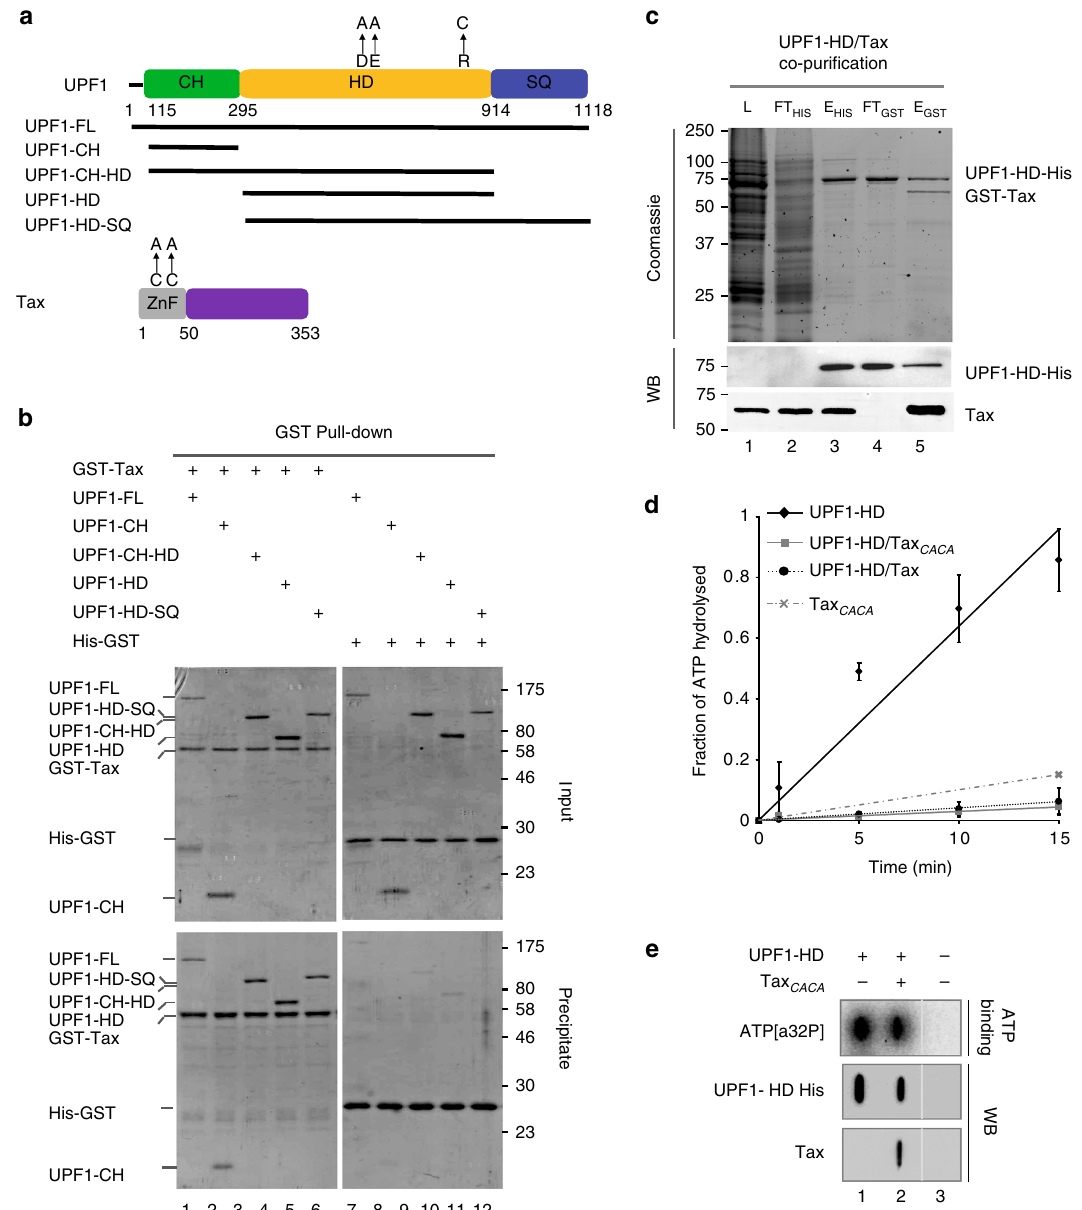
Fig. 2 HTLV-1 Tax interacts directly with UPF1-HD and inhibits its ATPase activity. a Schematic diagram showing the UPF1 and Tax domains and sites of mutant derivatives used for this study. Structural domains are represented by rectangles and the protein truncations used by black lines. b Pulldown experiment using GST-Tax (lanes 1 – 6) or GST-His tag (lanes 7 – 12) as bait. After incubation, protein mixtures before (input 20% of total) or after precipitation (precipitate) were separated on a 10% SDS-PAGE gel and visualised by coomassie staining. c A SDS-PAGE gel illustrating the co-puri fi cation of human UPF1-HD-His and HTLV-1 GST-Tax proteins by two sequential af fi nity puri fi cations (Nickel and Glutathione columns). Samples from the Escherichia coli lysate (lane 1: L), fl ow through (lanes 2 and 4: FTHIS and FTGST) and eluate (lanes 3 and 5: EHIS and EGST) fractions were loaded on the gel. The purity of the fractions was evaluated by coomassie staining (upper panel). The proteins were visualised by western blot analysis using anti-His and anti-Tax antibodies targeting UPF1 HD-His and GST-Tax, respectively (lower panels). d Graph showing the percentage of [ α - 32 P]ATP hydrolysed as a function of time by UPF1-HD (continuous line, diamond), UPF1-HD/Tax CACA (continuous line, square), UPF1-HD/Tax (dotted line, circle) and Tax CACA (dashed lane, cross) under conditions of steady-state ATPase turnover. Aliquots from the reaction mixture were quenched 0, 1, 5, 10 and 15 min before TLC chromatography (see Methods). The values are the mean of at least three biological replicates, and the error bars correspond to the SD. e UPF1-HD, UPF1- HD/Tax CACA complex and BSA proteins were spotted onto a nitrocellulose membrane and exposed to [ α - 32 P]ATP (top panel). The levels of the proteins used were also analysed by slot-blot on a different membrane. The membrane was incubated with anti-His and anti-Tax antibodies (middle and lower). Nonsigni fi cant lanes were removed as indicated by the vertical white line. Uncropped scans related to Fig. 2 are available in Supplementary Fig.